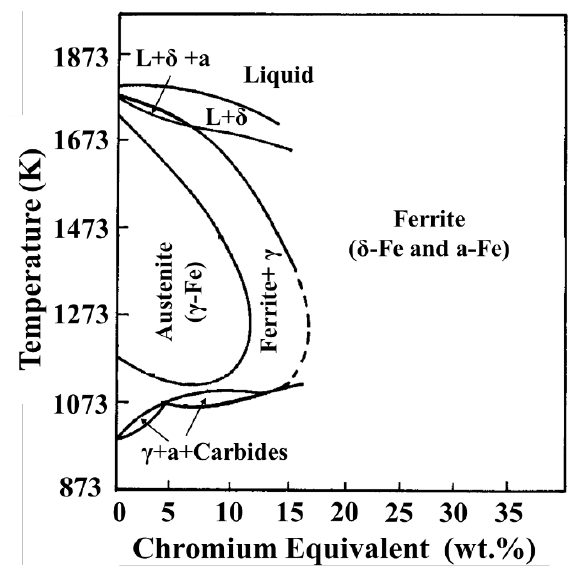
Figure 16. Pseudoequilibrium diagram showing the dependence of the existence of various phases on the chromium equivalent.